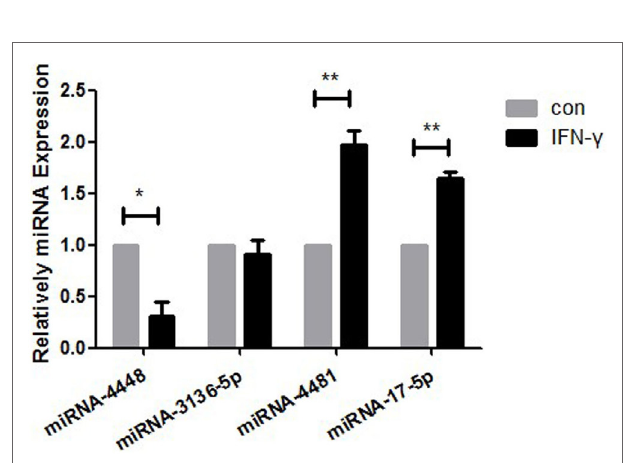
FigUre 2 | RT-PCR measurement of the expression levels of hsa-miR4448, hsa-miR3136-5p, hsa-miR4481, and hsa-miR17-5p in human corneal epithelial cells following 24-h treatment with 500 ng/ml IFN- γ . Data are shown as the mean ± SD. * p < 0.05; ** p < 0.01 vs. untreated control. Con, control; miRNA, microRNA.